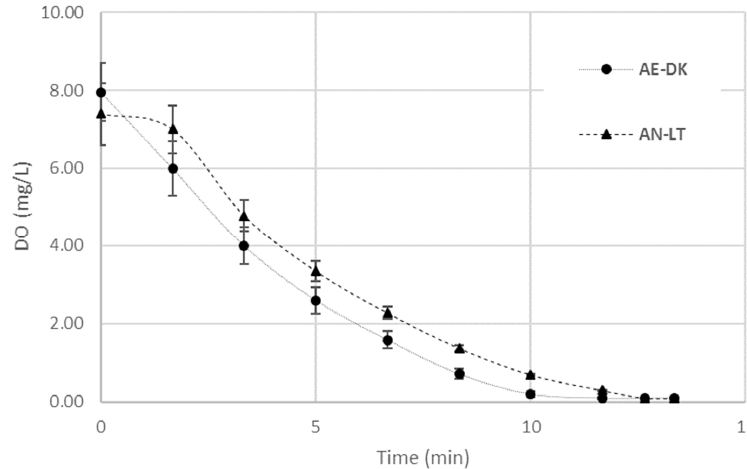
Figure 4. Dissolved oxygen with time during OUR test for R. capsulatus grown in aerobic ‐ dark (AE ‐ DK) and anaerobic ‐ light (AN ‐ LT) conditions.